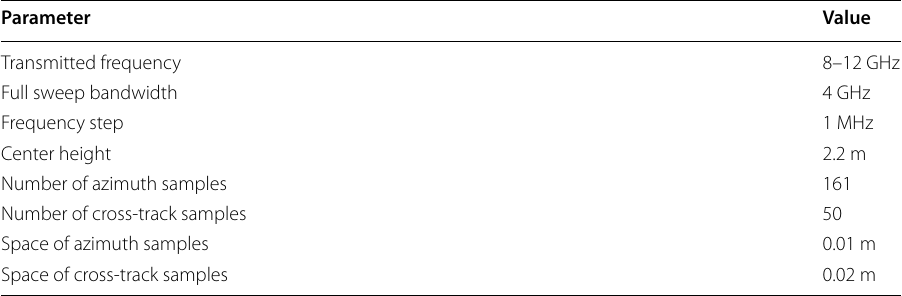
Table 5 Experiment parameters on real